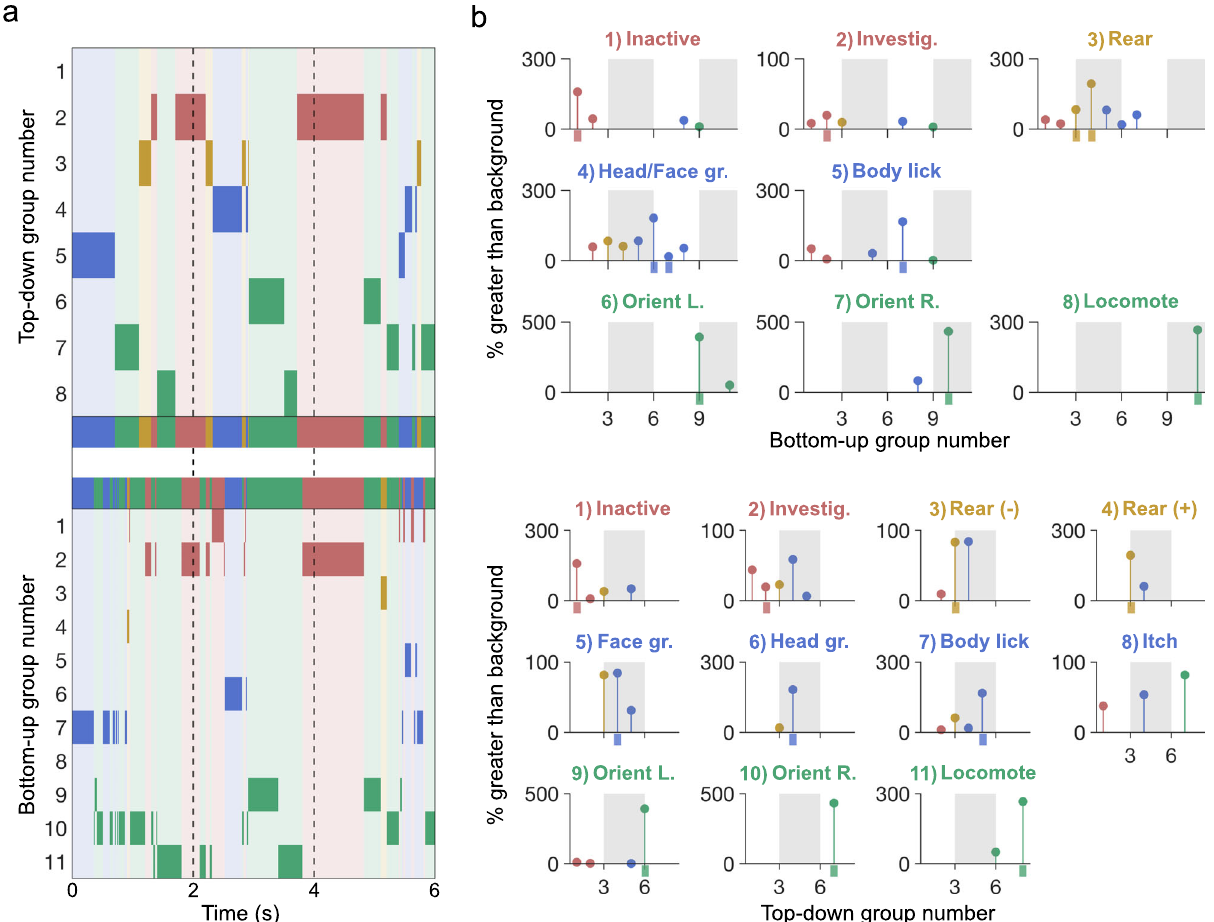
Fig. 4 Comparison of top-down to bottom-up camera angles. a Example ethograms of concurrent behavioral segmentation from the top-down view. The group de fi nitions for the behavioral groups are as titled in ( b ), Fig 1c. b To quantify the relationship between approaches, top-down video reference groups were mapped onto bottom-up target groups. Y-values indicate percentage of overlap greater than baseline distribution. Values < 0 not shown. c , d Same as ( a , b ), but using bottom-up as reference and top-down as target. Tick mark along x axis indicates correct target group. Source data are provided as a Source Data fi le for ( a – d